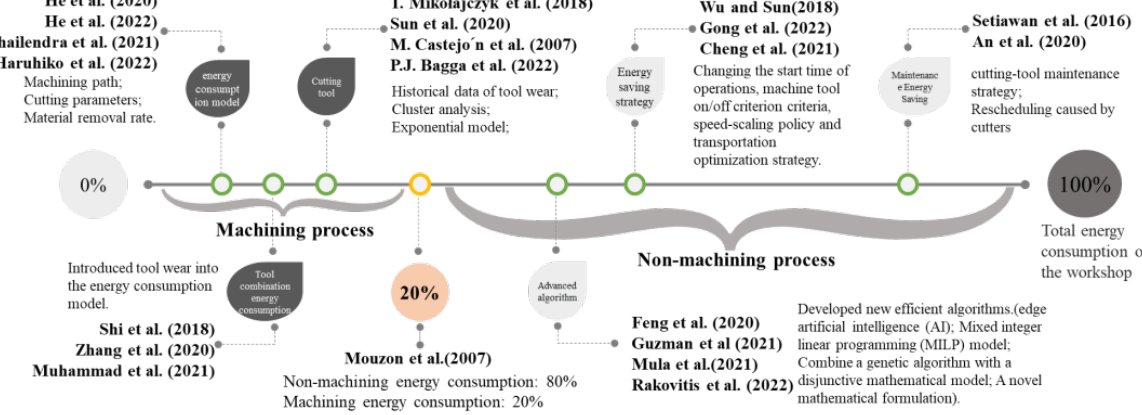
Figure 1. Analysis of energy-saving scheduling research status.